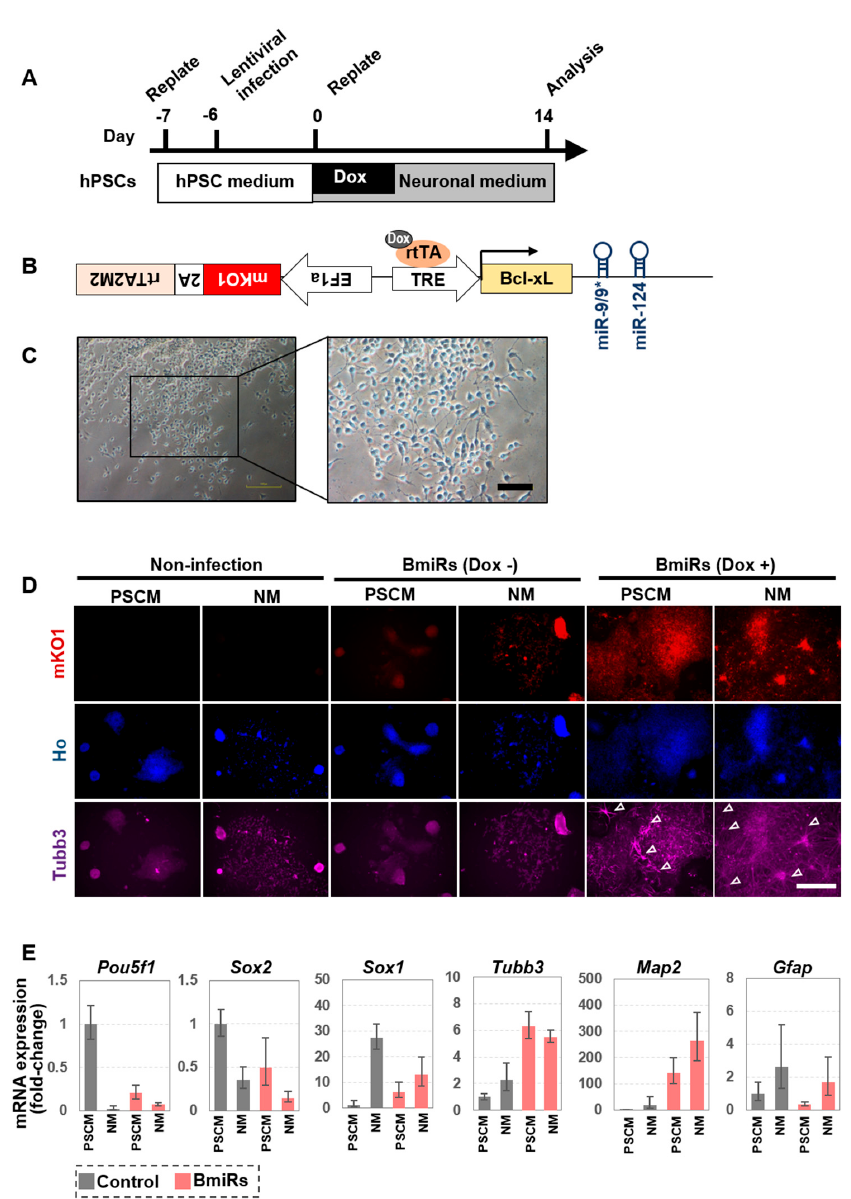
Figure 1. Bcl-xL genes (BmiRs) expression alone promotes neural differentiation from human pluripotent stem cells (hPSCs). ( A ) Overview of the protocol for differentiation into neurons by Tet-On-inducible Bcl-xL gene miR9/9*-124 overexpression. ( B ) Design of the lentiviral vector for Bcl-xL-miR-9/9*-124-mediated conversion of hESCs to neuronal cells. mKO1 and rtTA2M2 are abbreviations for monomeric Kusabira Orange, a fluorescent protein, and reverse tetracycline transactivator, respectively. ( C ) Representative bright field images illustrating the neuronally converted KhES1 cells at day 14. Scale bar: 100 µm. ( D ) Immunofluorescent (Tubb3) images of KhES1 in three different culture conditions: neuronal medium without Dox; hPSC medium or neuronal medium with 2 µg/ml Dox at day 20. Arrowheads indicate Tubb3+ neurite morphology. Scale bar: 500 µm. ( E ) Relative mRNA expression levels of Pou5f1 , Sox2 , Sox1 , Tubb3 , Map2, and Gfap in KhES1. (PSM: medium for pluripotent stem cells; NM: medium for neurons). Each data was standardized by the control cells cultured in PSM. (n = 4 independent experiments; mean ± SEM).